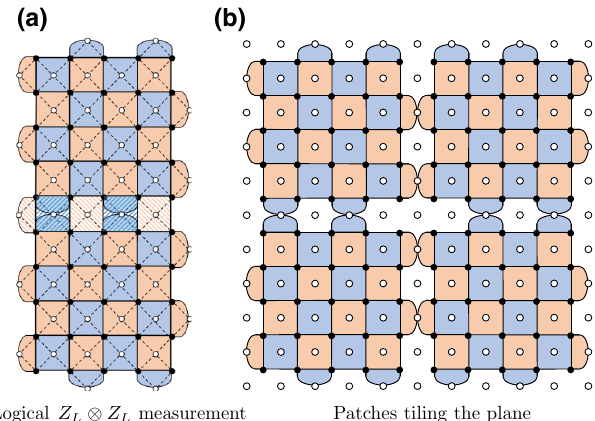
FIG. 15. (a) A logical Z L ⊗ Z L measurement is performed by lattice surgery in the following steps. (i) Stop measuring the weight-two stabilizers along the horizontal boundary between the patches. (ii) Reliably measure the bulk faces for a single ver- tically extended patch. Note that Z L ⊗ Z L can be inferred from the product of the outcomes of the newly measured red faces. This temporarily merges the patches to form a single extended surface code patch. (iii) Reliably measure once more the weight- two faces along the horizontal boundary between the patches.